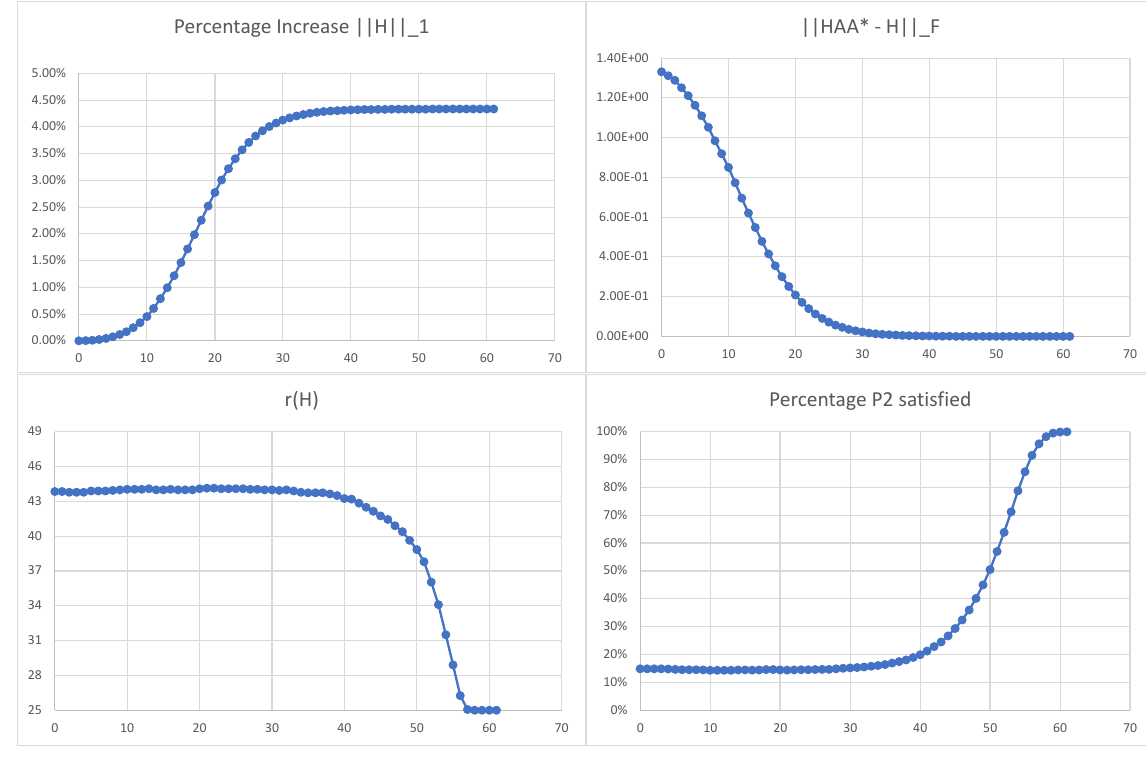
Figure 6 Penalized Frobenius method